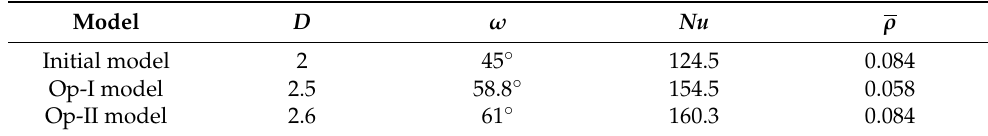
Table 8. Comparison of the optimization